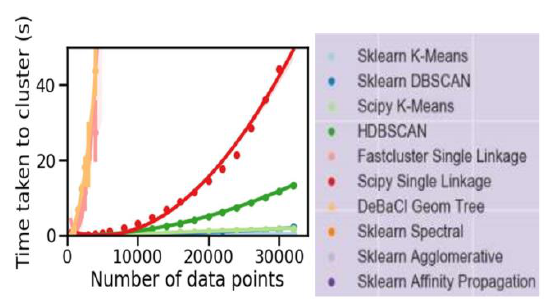
Figure 7. Clustering algorithm trend